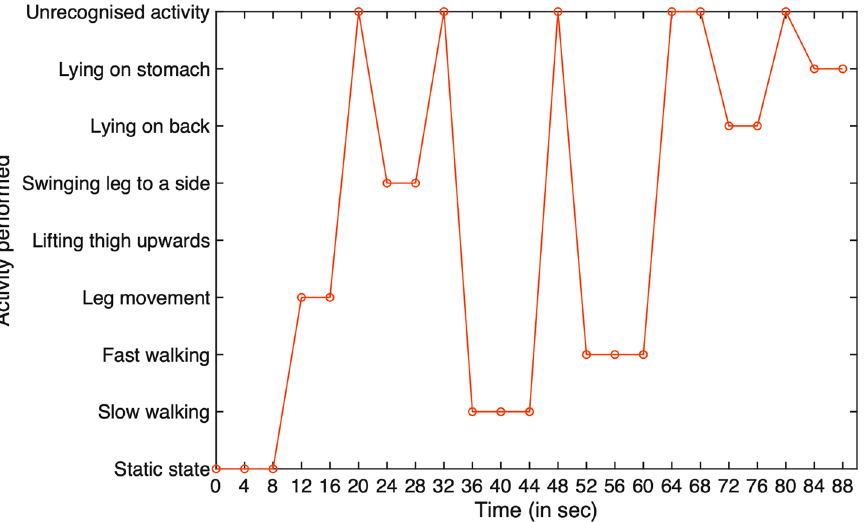
Figure 10. Sample representation of the real-time activity movement recognition performed by a subject during a day.